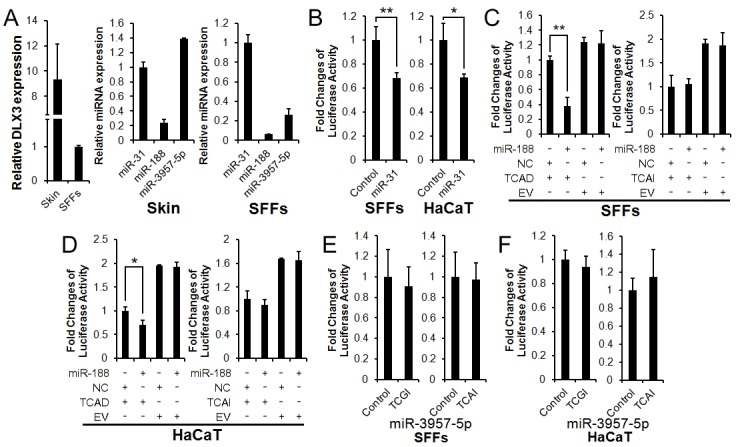
Effects of miR-188 on DLX3 3'UTR Luciferase Reporter activity.(A) Expression analysis of DLX3 and miRNAs in sheep skin and SFFs by real-time RT-PCR. The data were normalized against GAPDH (gene expression, left panel) and 5S ribosomal RNA (miRNA expression, middle and right panels), respectively. All PCRs were performed in triplicate; the data are expressed as the mean ± S.D. of three independent experiments. (B) Effects of miR-31 on DLX3 3'UTR luciferase reporter activity in SFFs and HaCaT cells, respectively. The graph is a mean of the three haplotypes (CCGI, TTAD or TCAD). About >30% suppression in the reporter activity was observed, compared to the control (cells cotransfected with psiCHECK2 vector and miR-31 mimic). (C, D) Effects of miR-188 mimic on DLX3 3'UTR reporter activity of psiCHECK2-TCAD and psiCHECK2-TCAI reporters in SFFs and HaCaT cells. MiR-188 mimc reduced the reporter activity of psiCHECK2-TCAD reporter by over 50%, but did not alter the reporter activity of psiCHECK2-TCAI reporter. NC: miRNA mimics negative control. EV: psiCHECK2 empty vector. (E, F) Effects of miR-3957-5p mimic on the reporter activity of psiCHECK2-TCGI and psiCHECK2-TCAI reporters in SFFs and HaCaT cells. MiR-3957-5p mimic caused no significant changes in the reporter activity of both psiCHECK2-TCGI and psiCHECK2-TCAI reporters. *p < 0.05; **p < 0.01.